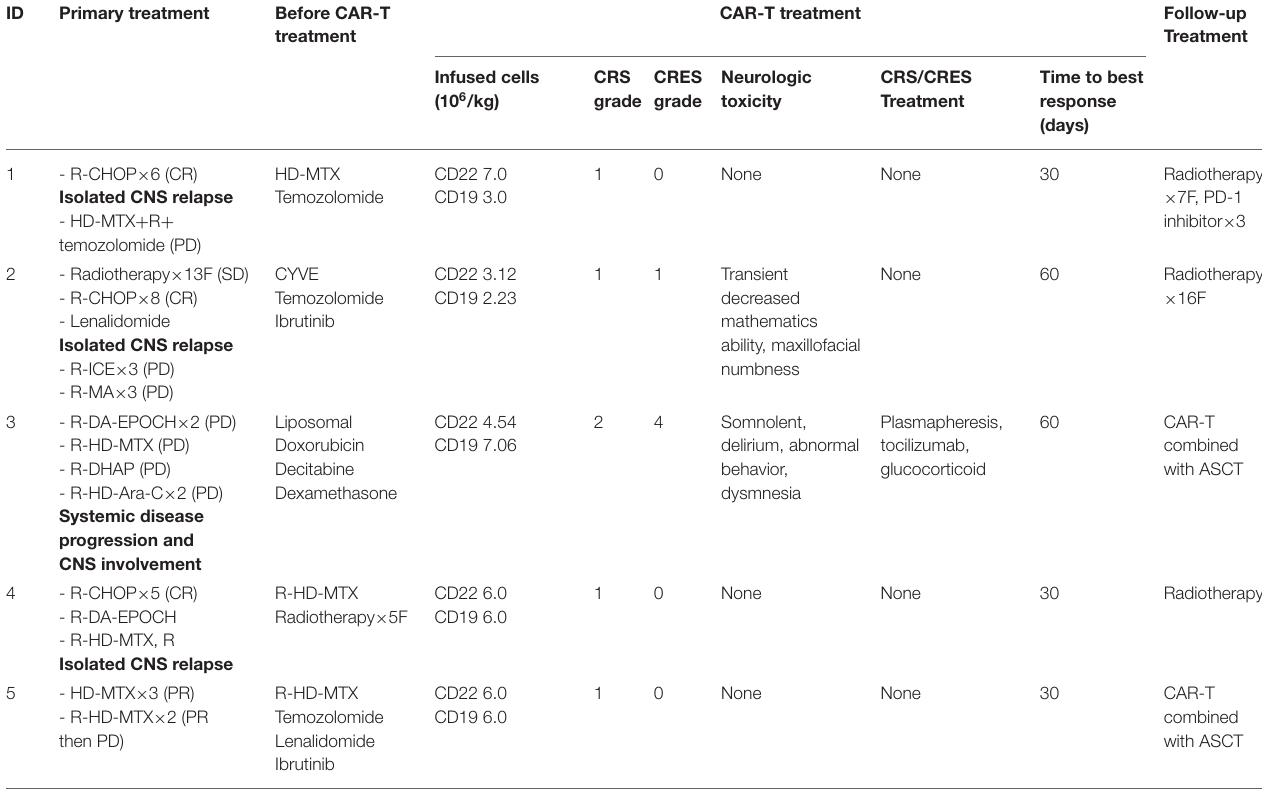
TABLE 2 | Treatment and effect of CAR-T cell therapy.